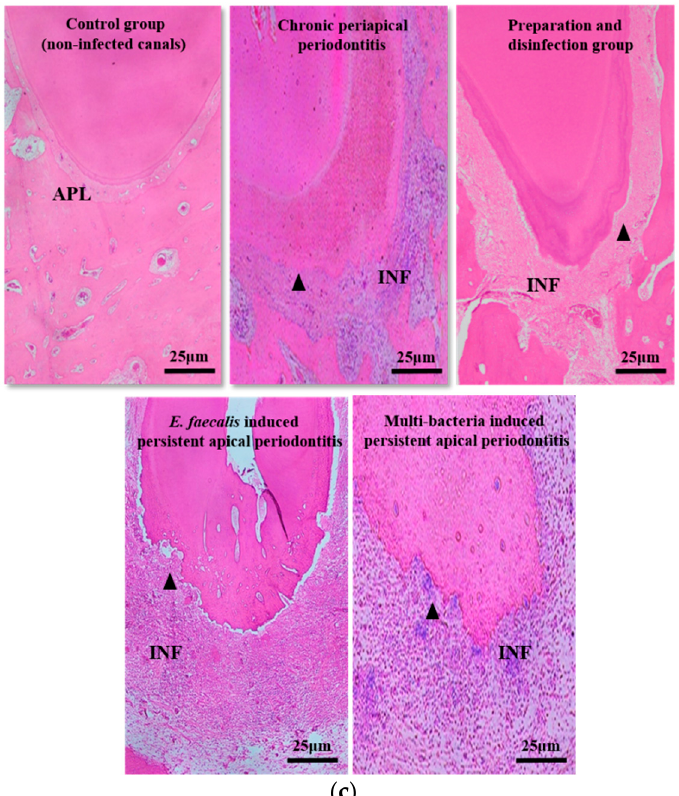
Figure 2. The volume and histopathological section of periapical lesions in each time point. ( a ) “C” represents the control group (non-infected canals), “I” represents the initial chronic AP group and “P” represents the root canal preparation and disinfection group; ( b ) “C” represents the control group (injected with sterile normal saline), “EP” represents E. faecalis - induced persistent AP and “MP” represents multi-bacteria-induced persistent AP; ( c ) histopathological images in each time points. Apical periodontal ligament (APL), areas of apical resorption (triangle), and chronic inflammatory reaction (INF) in the apical periodontal space. The apical shadow volume was tested through CBCT and calculated by MIMICS V21.0. Each value is mean ± SD ( n = 6) (*** p < 0.001).